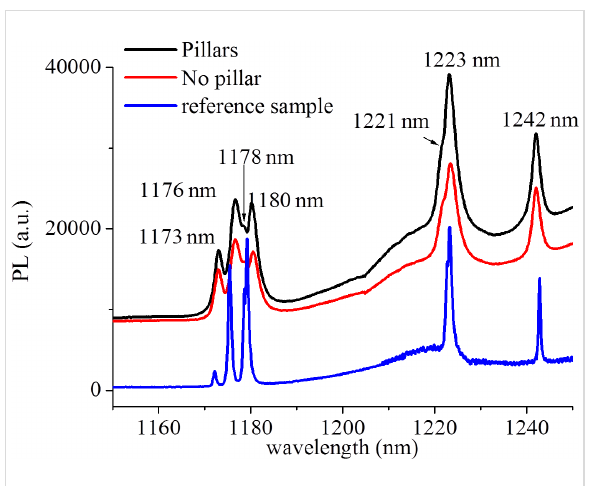
Figure 3: PL emission of sample 3 after excitation at 940 nm at 12 K, showing ZPL emissions at 1221, 1223, and 1242 nm [35,38,39] attri- buted to NV in 4H-SiC in the micropillars in addition to the ZPLs of the divacancy [34]. The ZPLs from 1173–1180 nm are due to V C V Si . The spectrum referred to as reference sample was characterized in [38,39] and is given here to prove the emission is indeed due to NV in 4H-SiC. quenching avalanche single-photon detectors for measuring the V Si emission and one equipped with InGaAs avalanche single- photon detectors (ID-Quantique 230 Peltier cooled to − 90 °C, quantum efficiency maximum of 25% at 1300 nm and set at